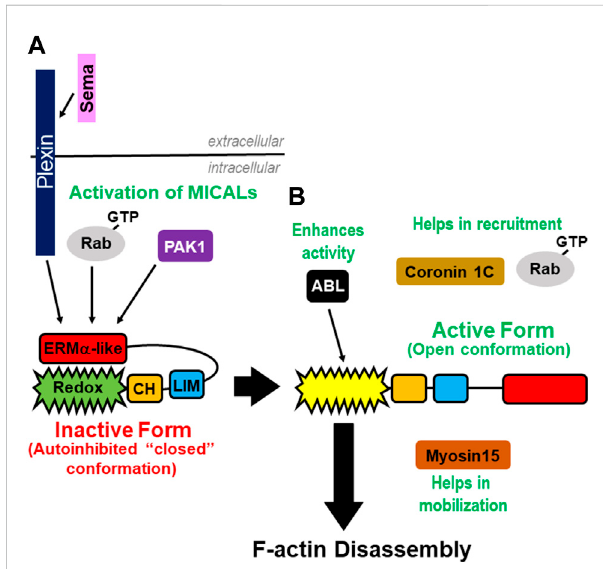
FIGURE 3 Regulation of the MICAL ’ s activity. (A) Plexins and GTP-bound Rab proteins bind the MICAL ’ s ERM α -like domain to relieve the MICAL ’ s autoinhibition. PAK1 kinases also play a role in relieving the MICAL ’ s autoinhibition by phosphorylating residues within the MICAL ’ s C-terminus. (B) Rabs and Coronin 1C are involved in the MICAL ’ s translocation and positioning. Myosin15 is involved in moving the MICAL ’ s into a new region to propagate its F-actin disassembly